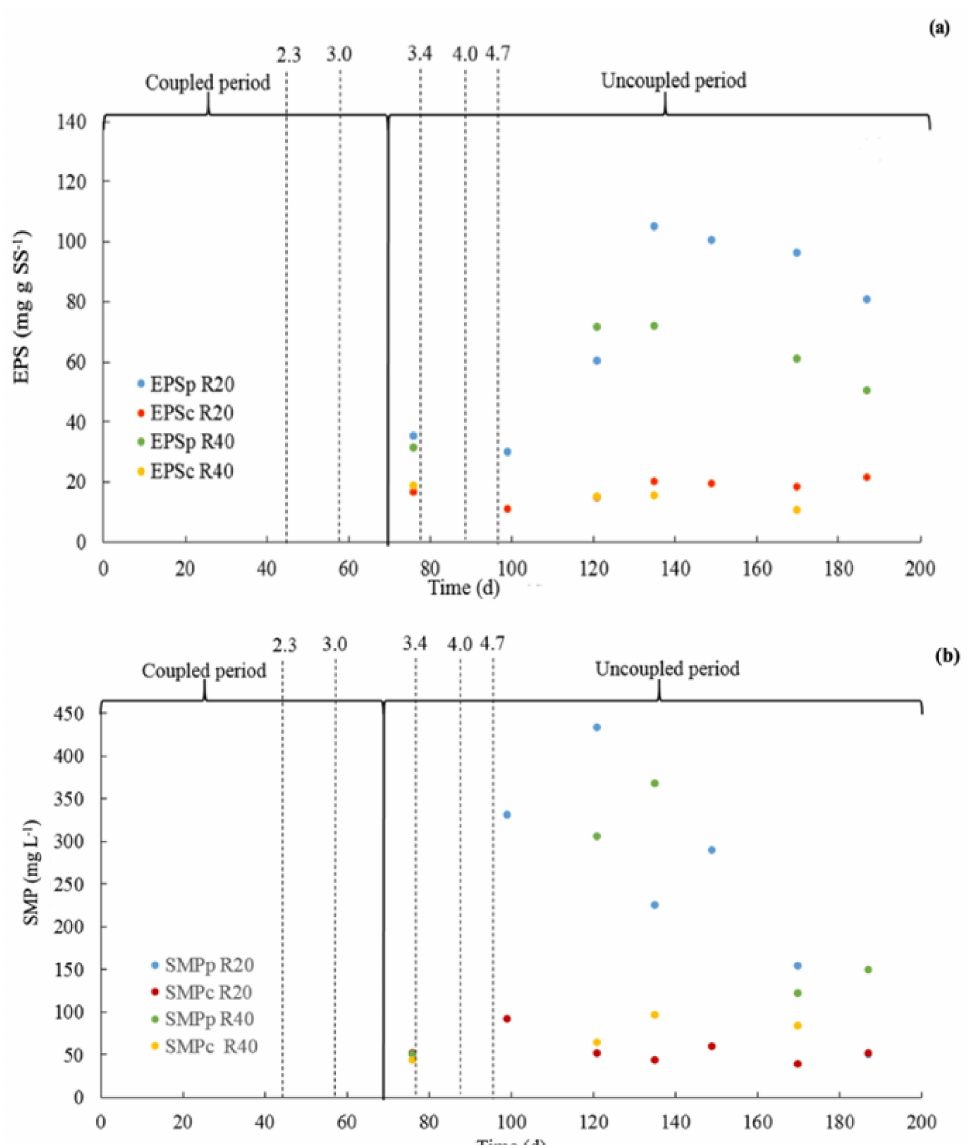
Figure 5. ( a ) Extracellular polymeric substances (EPS) fractions, and ( b ) Soluble microbial products (SMP) fractions for the R20 and R40 reactors over time. The dotted lines indicate the applied OLR (g COD/L